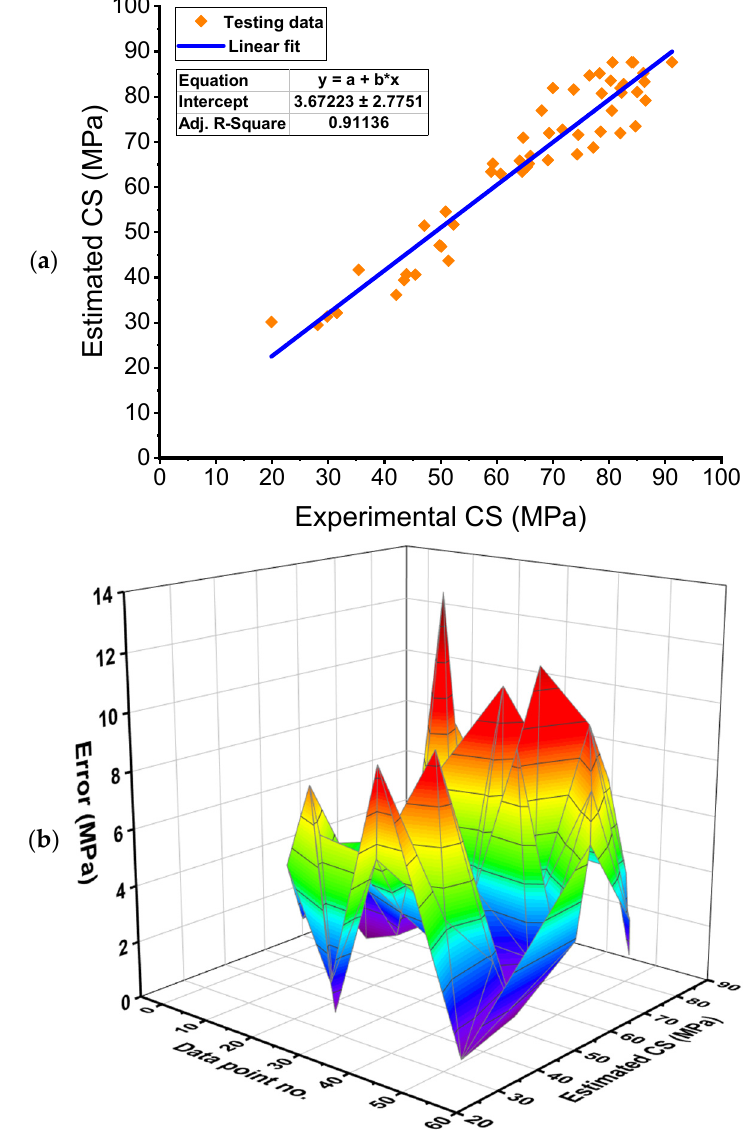
Figure 9. Bagging regressor model: ( a ) Relation between real and anticipated outcomes; ( b ) Disper- sion of anticipated results and errors. Error = | Experimental result − Estimated result |